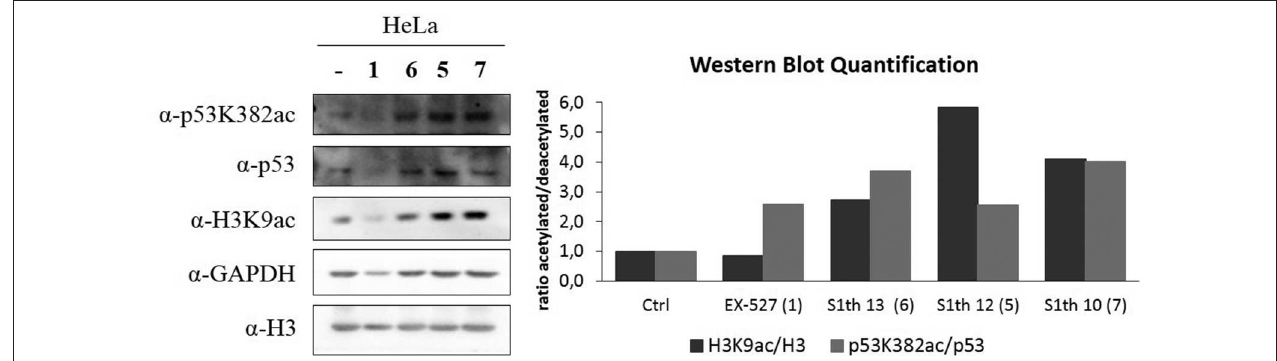
FIGURE 6 | Western blot analysis of acetylation status of p53K382 and H3K9 in HeLa cells. A α -GAPDH antibody was used as a loading control. Histone H3 and p53 expression was monitored by α -H3 and α -p53 antibodies and was not altered by application of the inhibitors, while α -H3K9ac and α -p53K382ac indicate the impact on acetylation status upon inhibitor treatment. 1 (EX-527) was used as a positive control, however it did not show clear hyperacetylation of H3K9. In contrast, a clear effect on acetylation of these Sirt1 targets is observed when 5 , 6 , and 7 ( S1th 12 , 13 , 10 resp.) are applied. Quantification of the shown blot is displayed as the ratio between acetylated and deacetylated protein in relation to a control where no inhibitor was